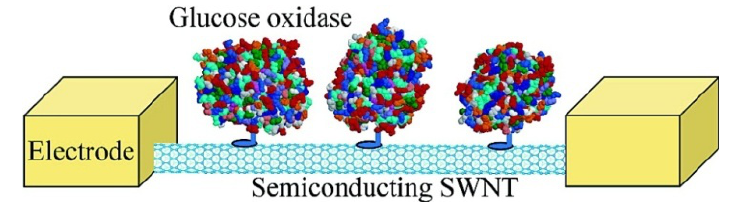
Figure 4. Schematic picture of two electrodes connecting a semiconducting SWCNT with GOD enzymes immobilized on its surface. Reprinted with permission from